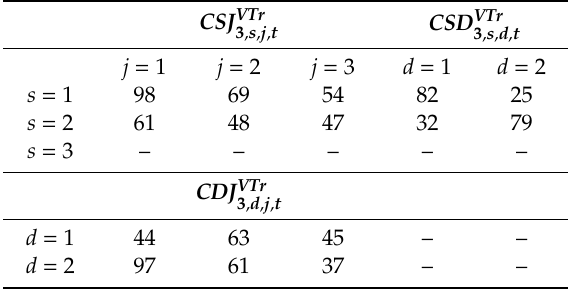
Table A9. Variable transportation cost per unit of product 3 ( € ) (considered here the same for any t ).